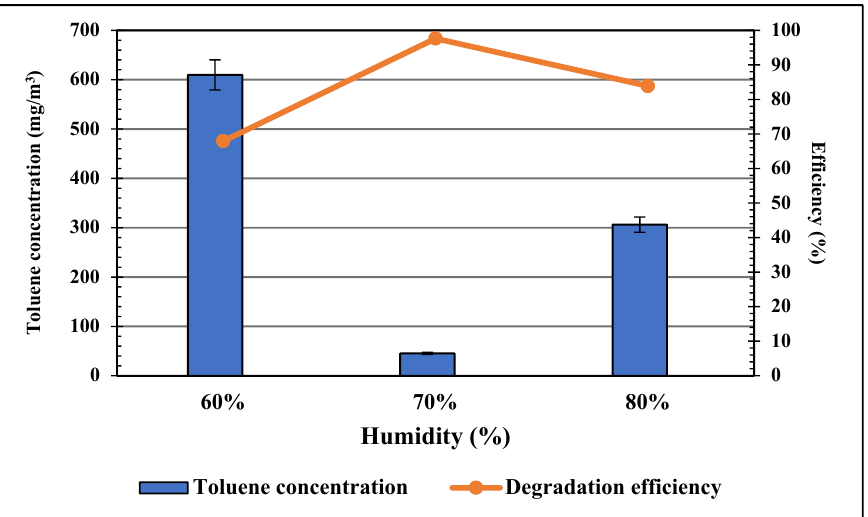
Figure 10. Effect of humidity on photodegradation efficiency of toluene at 1.5 mol% Ir, 350 mL/min. From our findings, it is indicated that toluene is a molecule hard to be degraded pho- ene (1900 mg/m 3 ). This is a remarkable result in our work, so we have measured the CO (cid:2870)